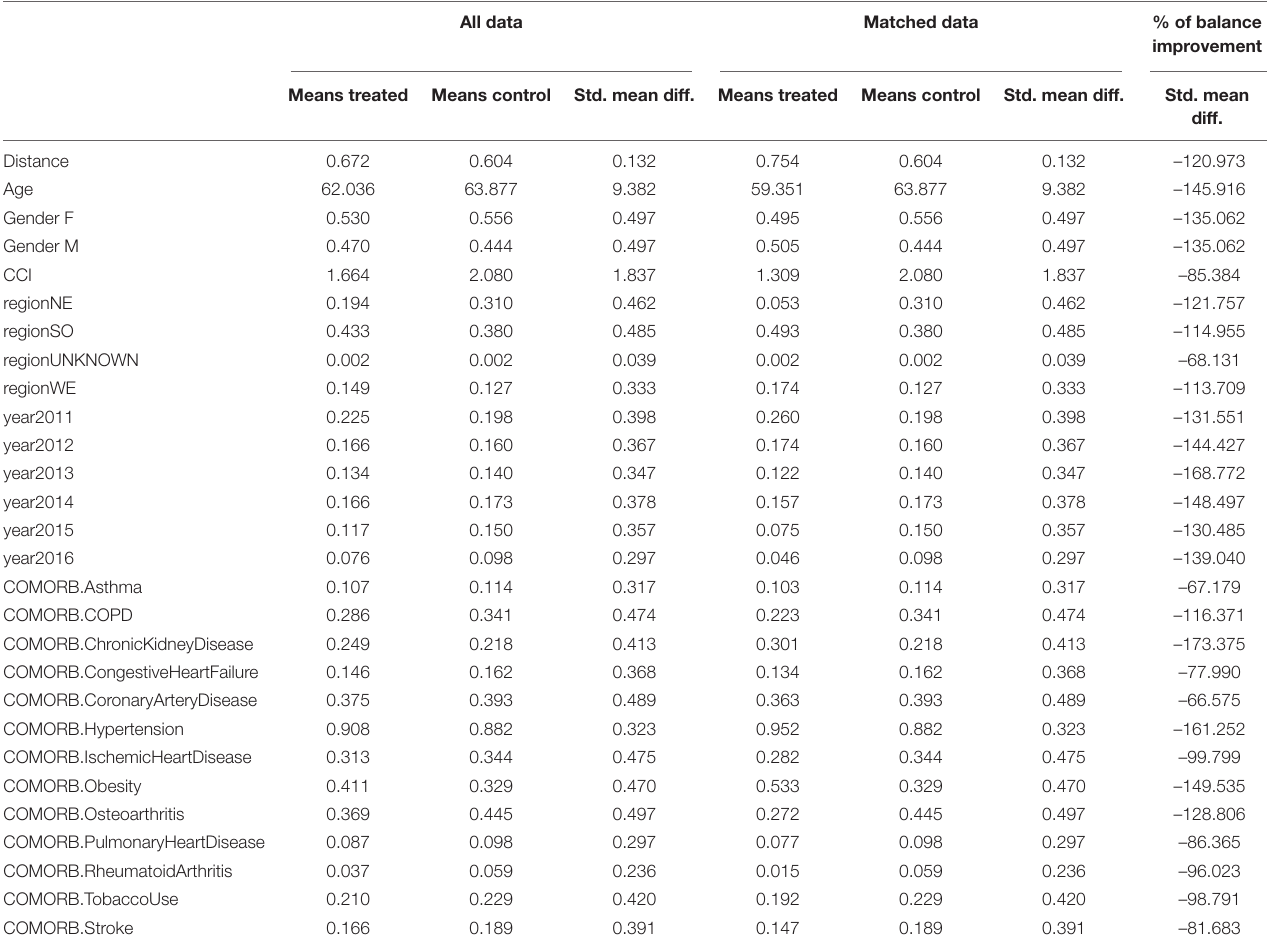
TABLE 5 | Summary of balance.